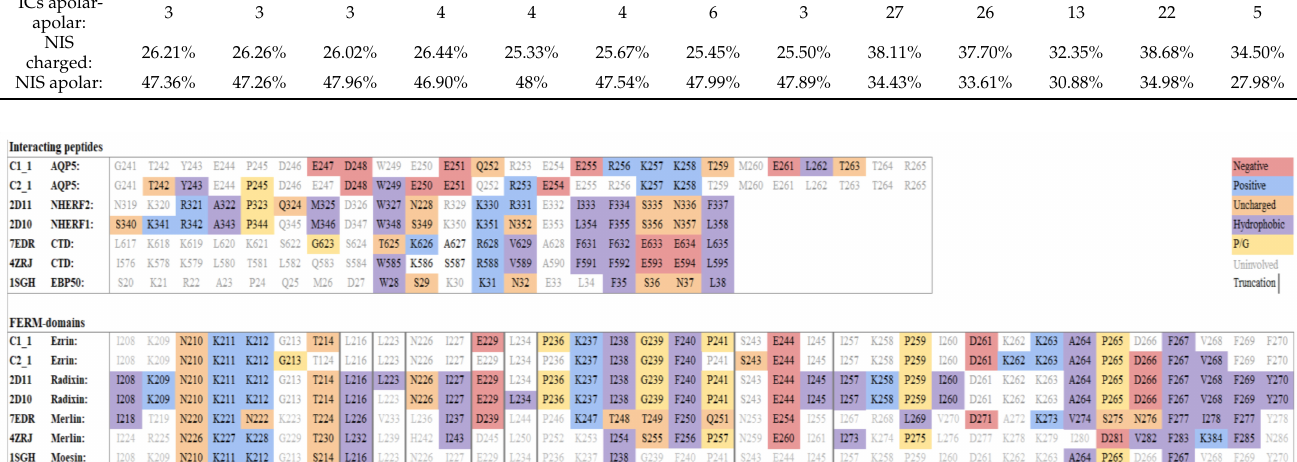
Figure 3. Comparison of interacting residues in FERM–peptide complexes. Residues involved in the interaction in the interacting peptides, as well as the FERM domains, were identified using PRODIGY and highlighted in color according to the type of residue. Grey lines indicate truncations of the sequences for visual purposes. The used sequences are as follows: C1_1, AQP5 C-terminus model 1 (comparative modeling) with human ezrin FERM; C2_1, AQP5 C-terminus model 2 (TrRosetta) with human ezrin FERM; 2D11 and 2D10, Mus musculus radixin FERM with NHERF-2 and NHERF-1 peptides, respectively; 7EDR, Drosophila melanogaster Merlin FERM with Merlin C-terminal domain; 4ZRJ, Human Merlin with C-terminal domain; 1SGH, Human Moesin FERM with EBP-50 (also known as